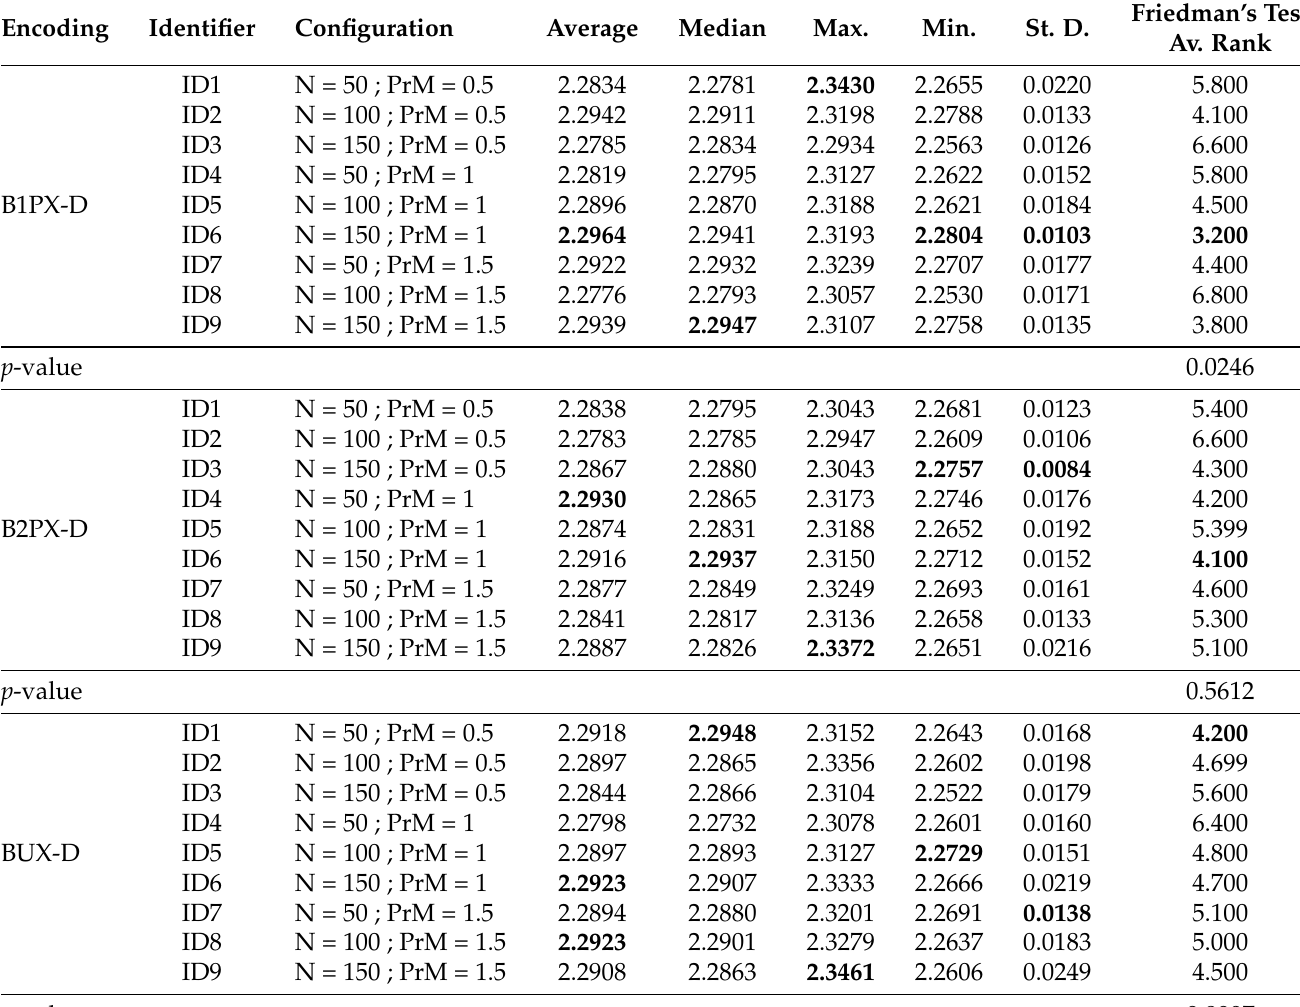
Table 10. Hypervolume statistics (Binary